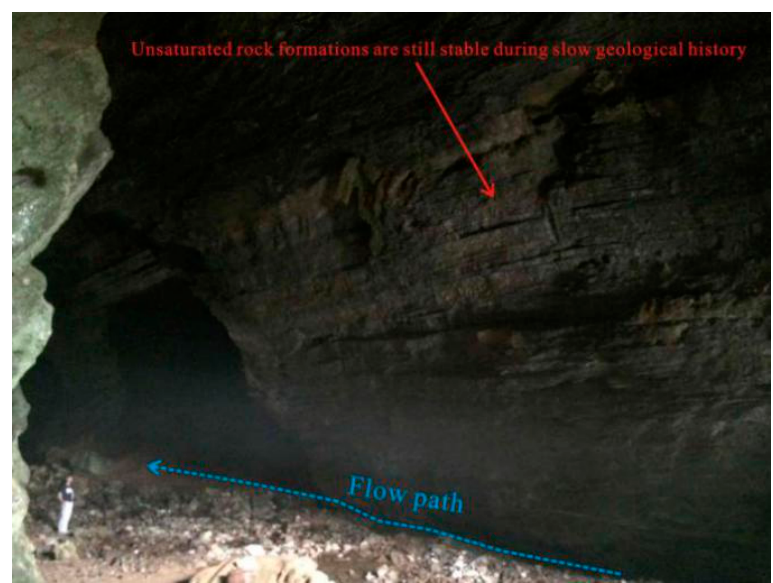
Figure 8. Actual development of the horizontal underground river channel in the Wangjiaba section.